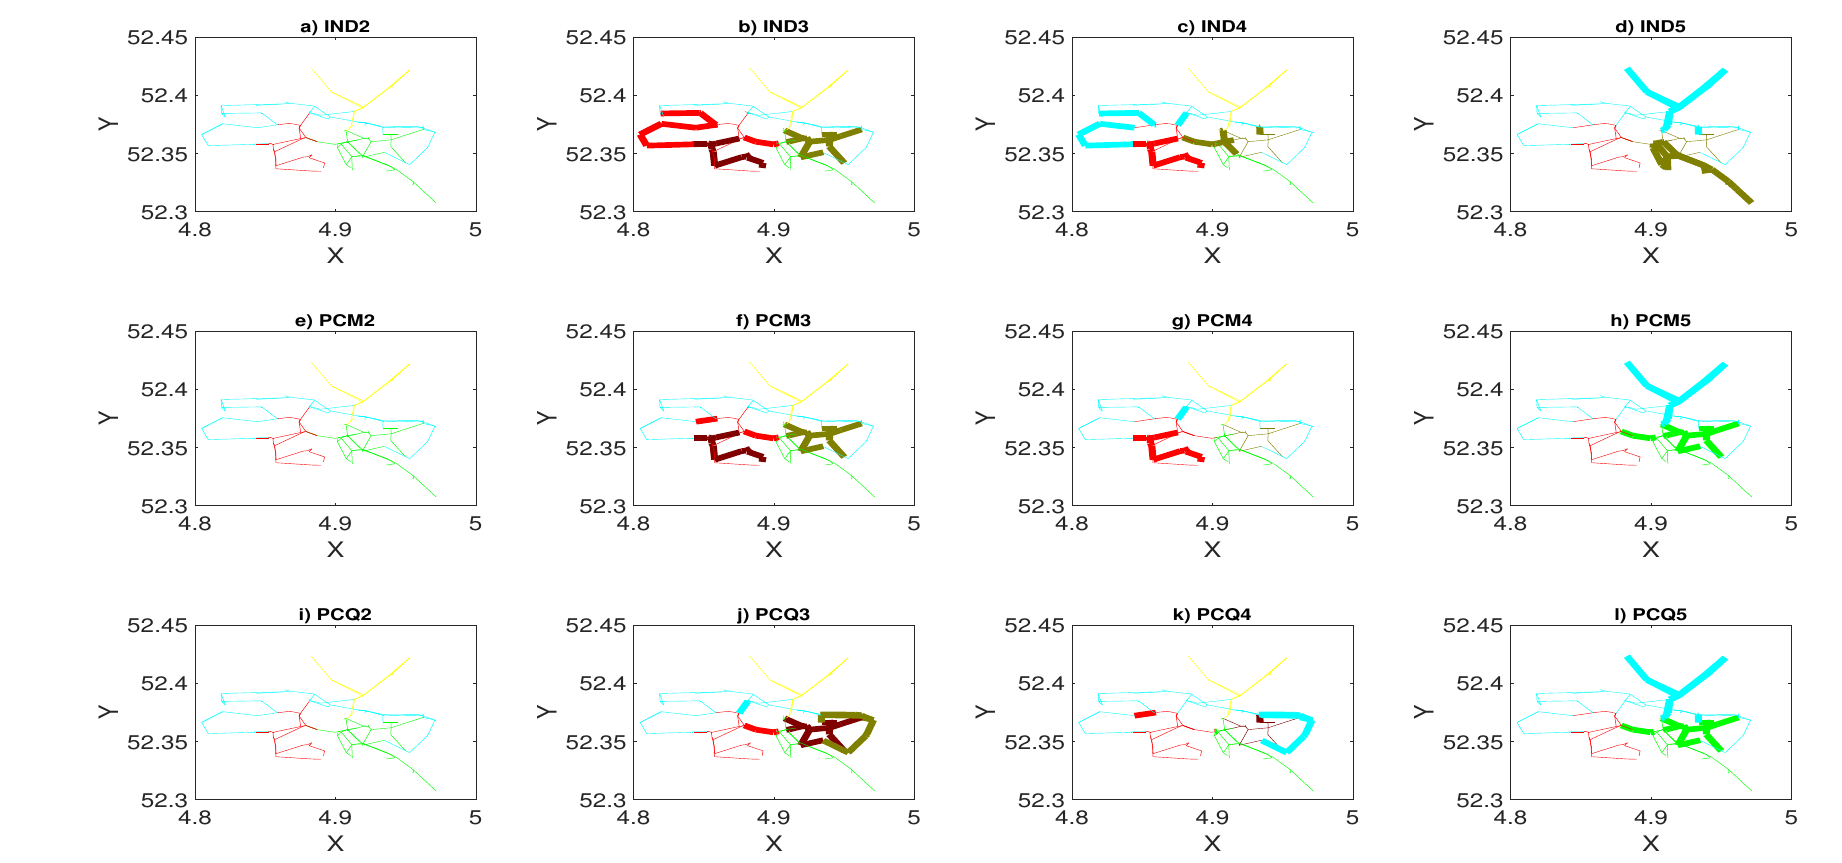
Figure 19. Clustering results for time periods from t = 2 to t = 4 for the IND, PCM and PCQ methods in the case of time period = 10